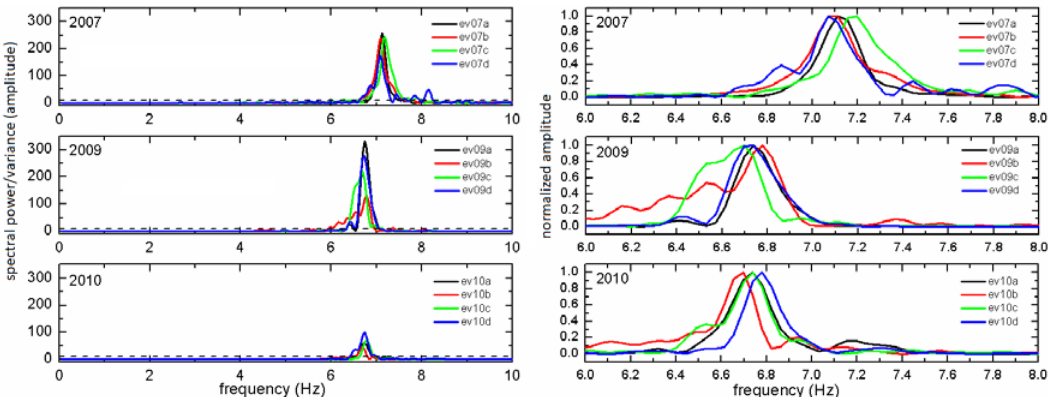
vertical oscillations at the midspan of the bridge for selected surveys (events, curves marked with a different colour). Sensors 2018 , 18 , 3867